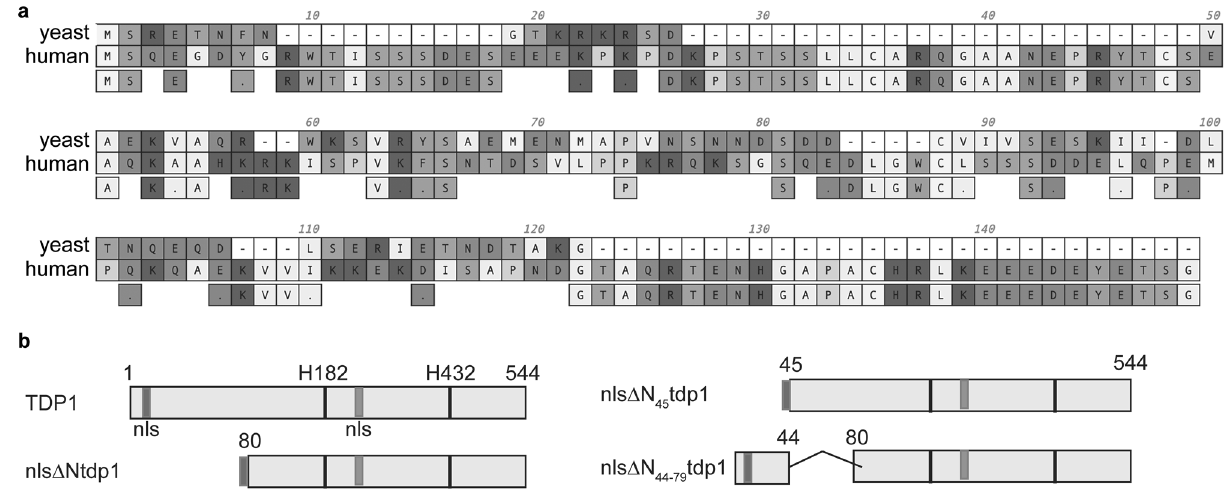
Figure 1. Tdp1 N-terminal domain sequence and constructs. ( a ) Comparison of yeast and human Tdp1 NTD amino acid sequence (alignment using MacVector 17.5.6). ( b ) schematic overview of N-terminal domain constructs used in this study. nls: nuclear localization sequence; ΔN: amino acid deleted region; numbers amino acid residue number; H: